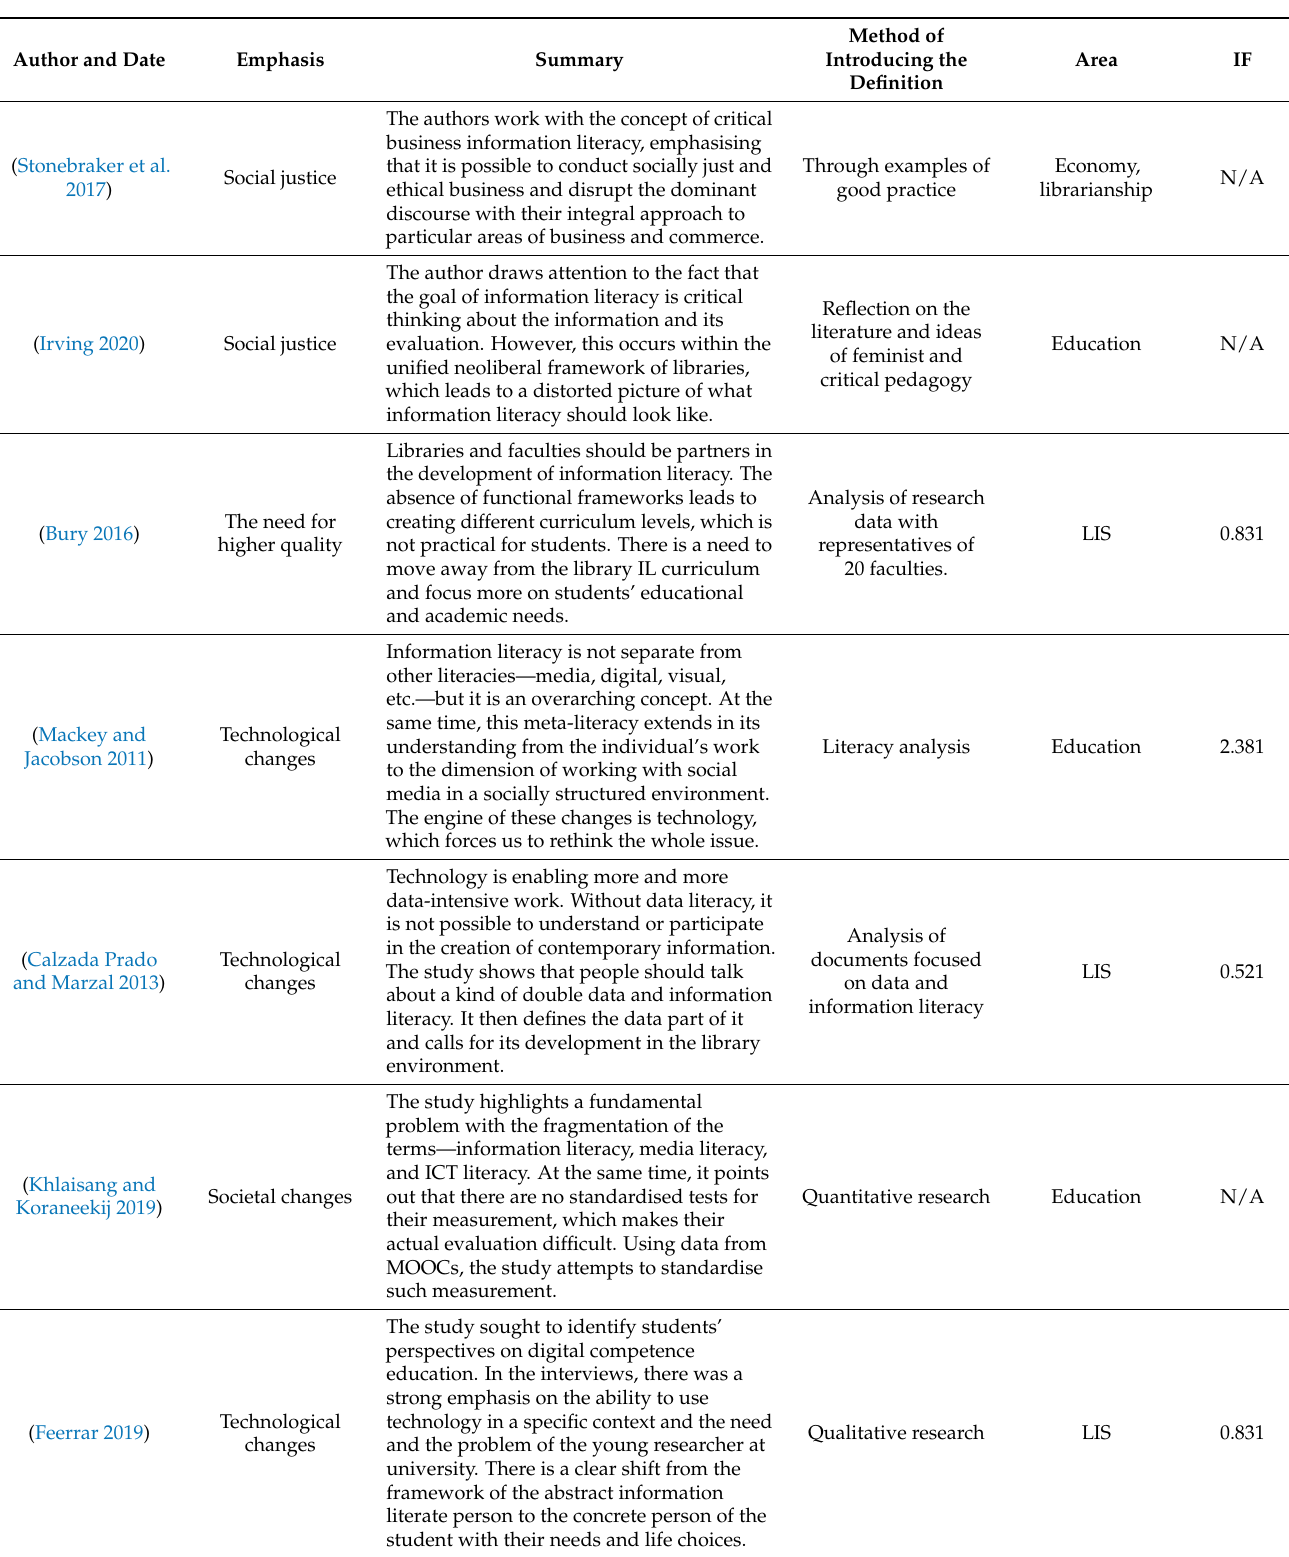
Table A1. Overview of the analysed